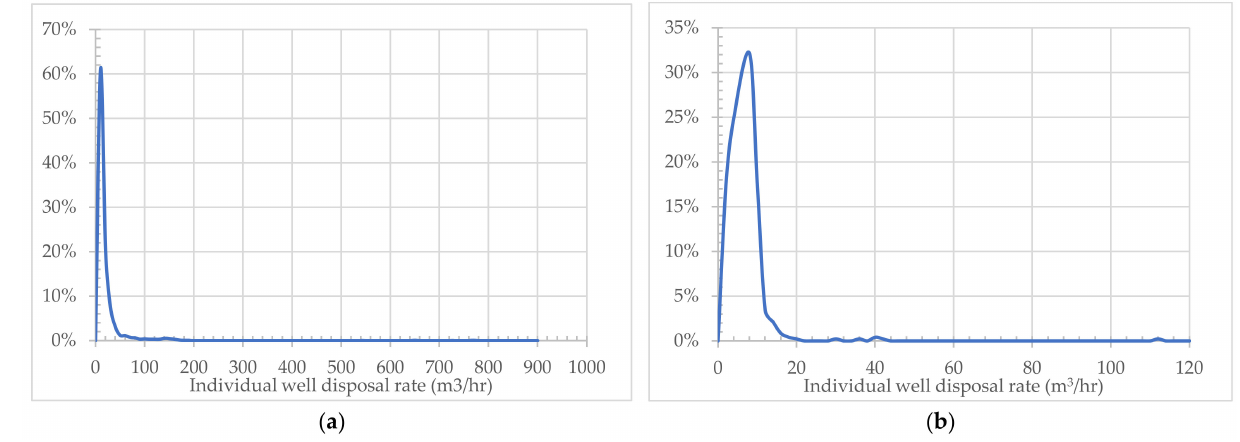
Figure A31. Historical per-well water injection rate ( X -axis) frequency ( Y -axis) distributions (January 1962–December 2022) in ( a ) the Keg River Formation; ( b ) the Muskeg Formation.